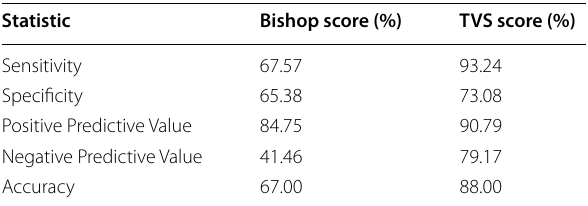
Table 4 Comparison of sensitivity, specificity, and predictive